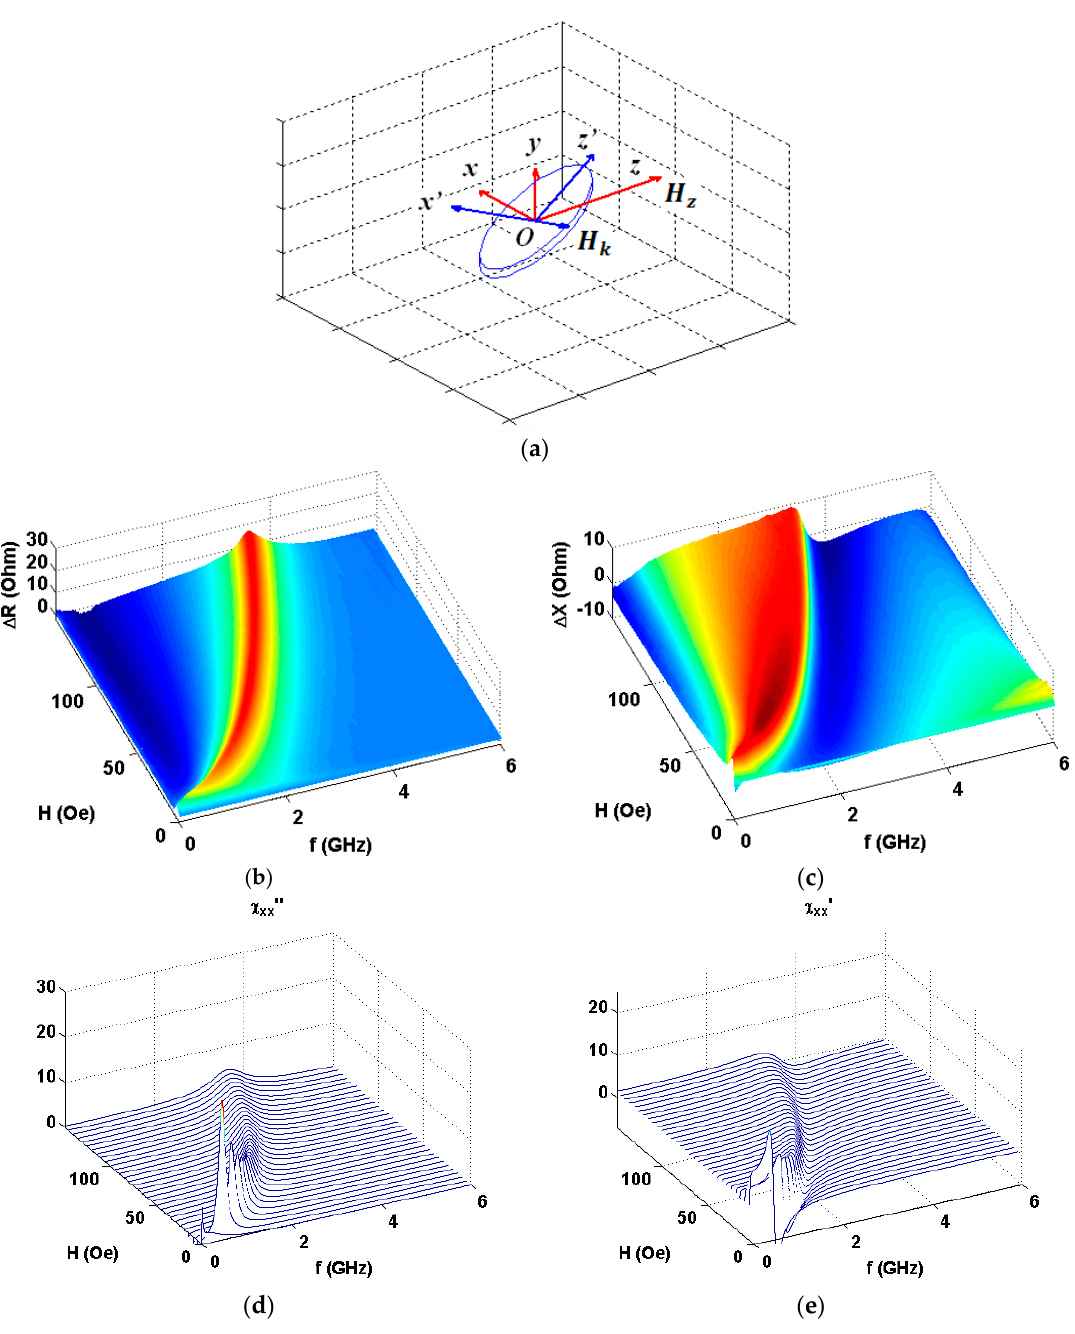
Figure 5. Coordinate system for vector H directed under the angle α = 60° with respect to high frequency field h ( a ). Experimental data for the applied field and frequency dependences of the real ( b ) and imaginary ( c ) parts of the impedance of GMI element. Model calculations for imaginary ( d ) and real ( e ) parts of the susceptibility tensor corresponding to the real and imaginary parts of the impedance variations accordingly.